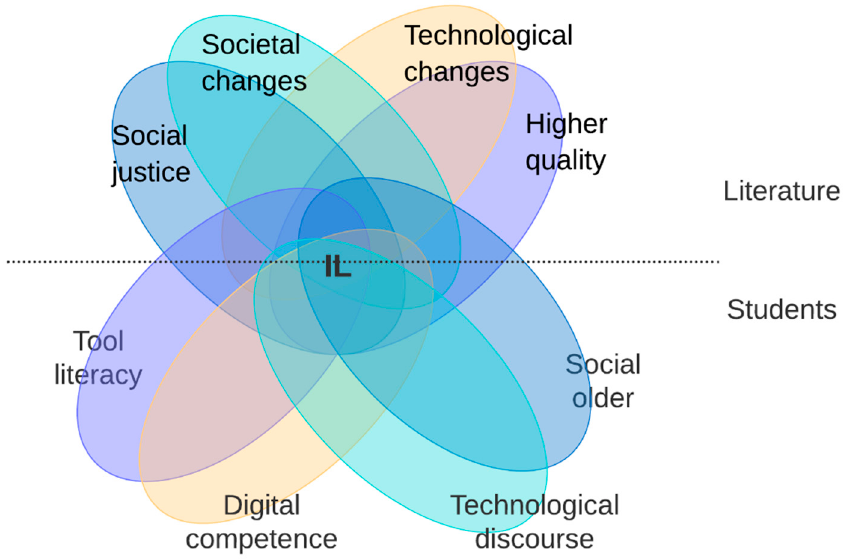
Figure 1. Relatedness of the discourses identified in the student responses (bottom) and in the literature (top), marked with the same colour. The intersection of all these discourses is information literacy (IL). For clarity, in Figure 1, we use the abbreviation from “Information literacy is the ability to assess, locate and organize information” to “Digital competence”, maintaining the nomenclature used in DigComp (Carretero et al. 2017). Figure 1 author is the author of this study.